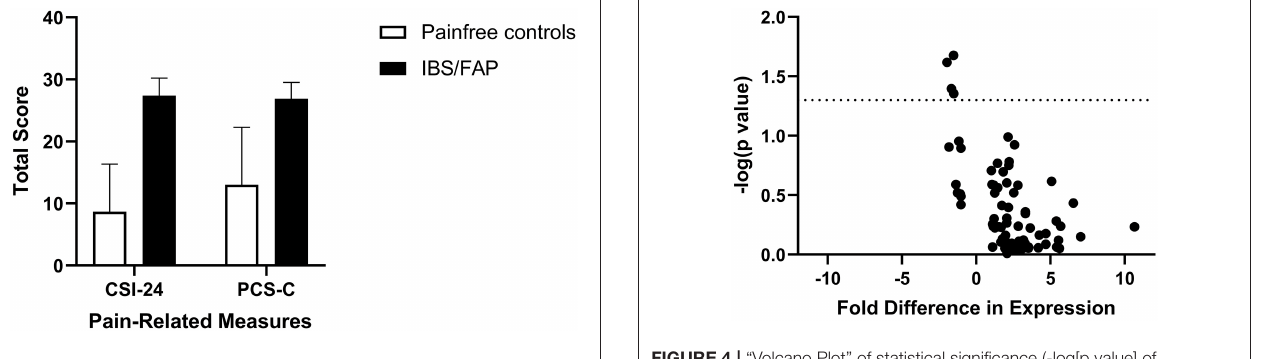
( t = 1.329, p = 0.20), and PTGES3 ( t = 2.017, p = 0.06).